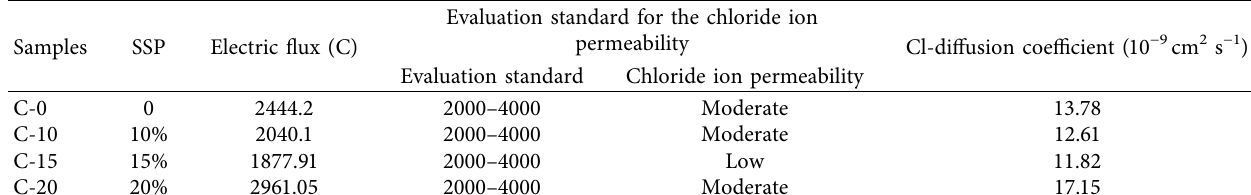
Table 6: The chloride ion permeability of